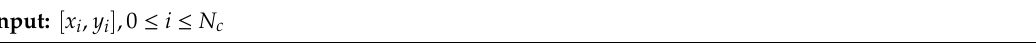
Algorithm 1 The nearest neighbor algorithm.